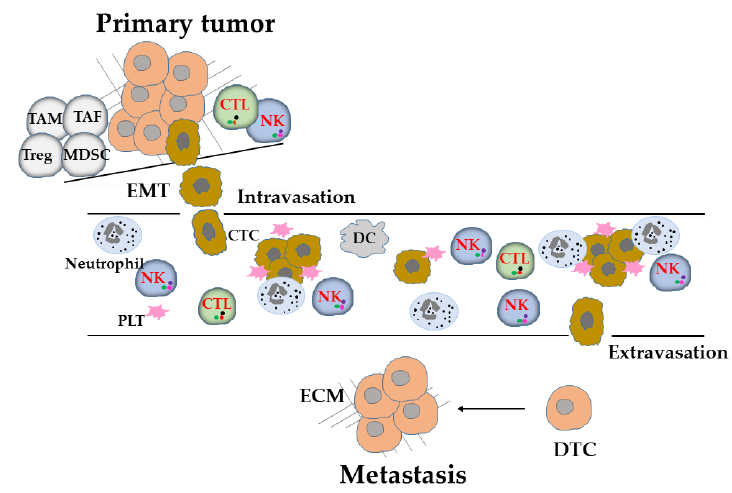
Figure 1. Metastatic cascade and immunosurveillance. Primary tumor cells undergo epithelial-to-mesenchymal transition (EMT) within tumor-cell-extrinsic factors in nutritional, stromal, and immunological microenvironments endowed with distinct metastatic potential. The EMT trans-differentiated cells detach from the primary tumor and interact with and remodel the extracellular matrix (ECM) for intravasation, leaving the protection of the immunosuppressive tumor microenvironment. They reach the circulation, which make them more vulnerable to attacks by immune effector cells, particularly, NK cells, which can directly and indirectly interact with circulating tumor cells (CTCs) to control metastasis. However, they survive as polyclonal clusters of CTCs and cooperate with platelets and neutrophils, which shield them and alter the function of NK cells as a mode of escape from immunosurveillance until they encounter conditions that are permissive for extravasation and lodge at secondary sites. They can persist in a relatively silent state as disseminated tumor cells (DTCs) or micrometastatic tumor cells for a highly variable period of time, until they resume proliferation to establish a clinically detectable metastatic disease. Abbreviations : TAF, tumor-associated fibroblast; CTC, circulating tumor cell; CTL, cytotoxic T lymphocyte; DC, dendritic cell; DTC, disseminated tumor cell; ECM, extracellular matrix; EMT, epithelial-mesenchymal transition; MDSC, myeloid-derived suppressor cell; NK, natural killer cell; PLT, platelet; TAM, tumor-associated macrophage; Treg, regulatory T cell.